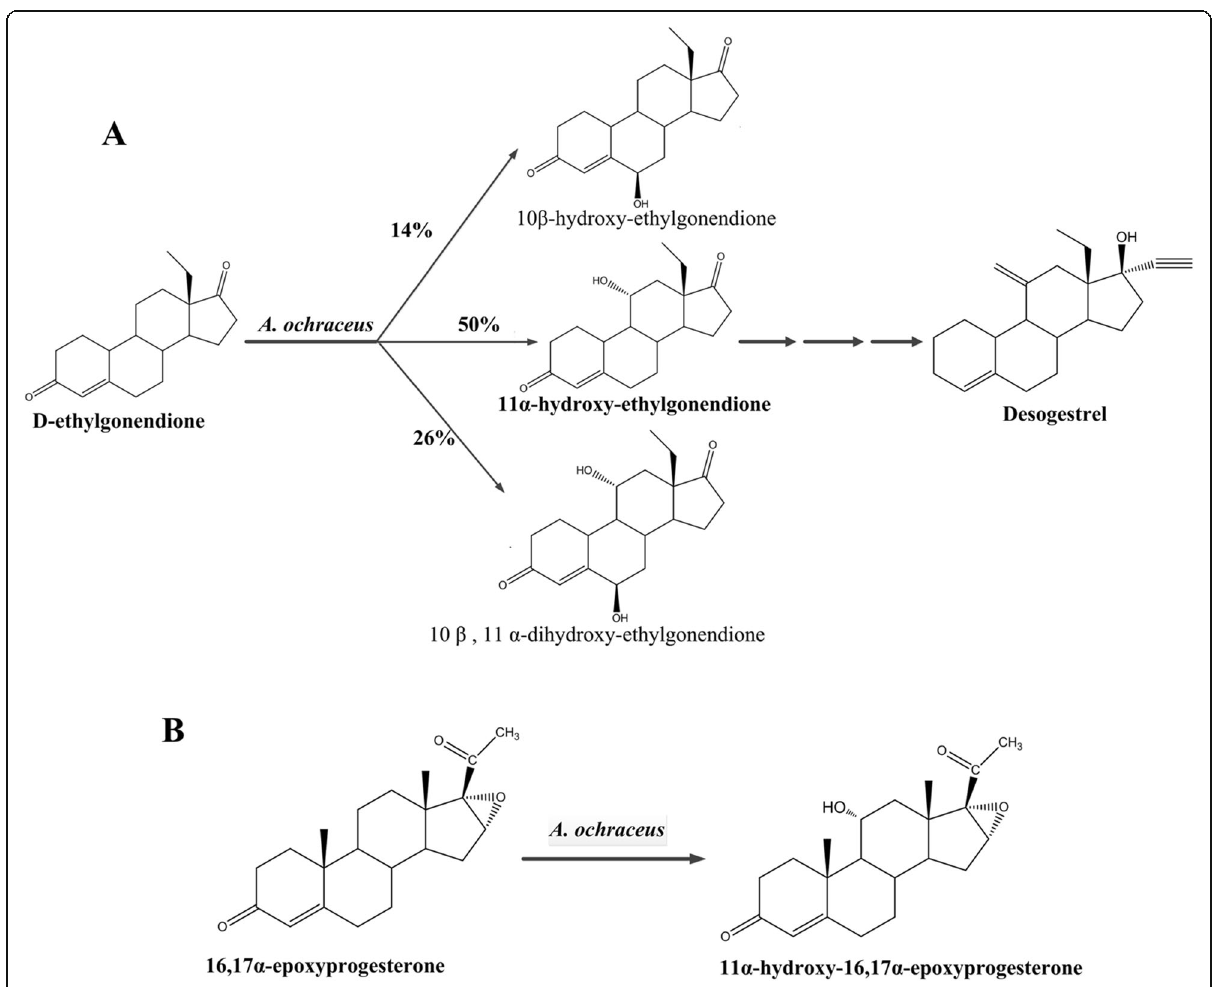
Fig. 1 Biotransformation of a D-ethylgonendione and b 16,17 α -epoxyprogesterone by Aspergillus